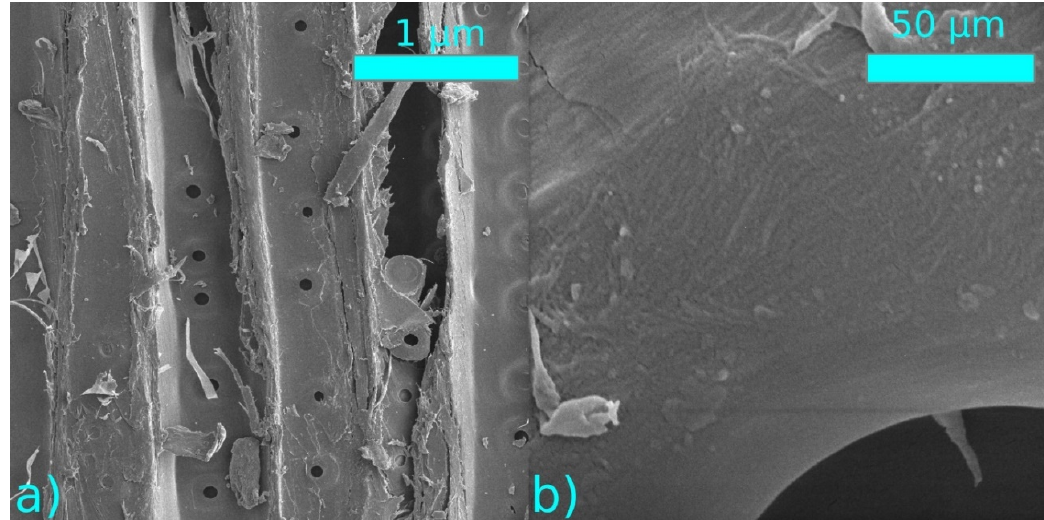
Figure 10. SEM images of plasma-treated samples at a distance of 0.15 mm from the electrode ( a ) 1000× magnification, ( b ) 50,000× magnification. Coatings 2020 , 10 , x FOR PEER REVIEW